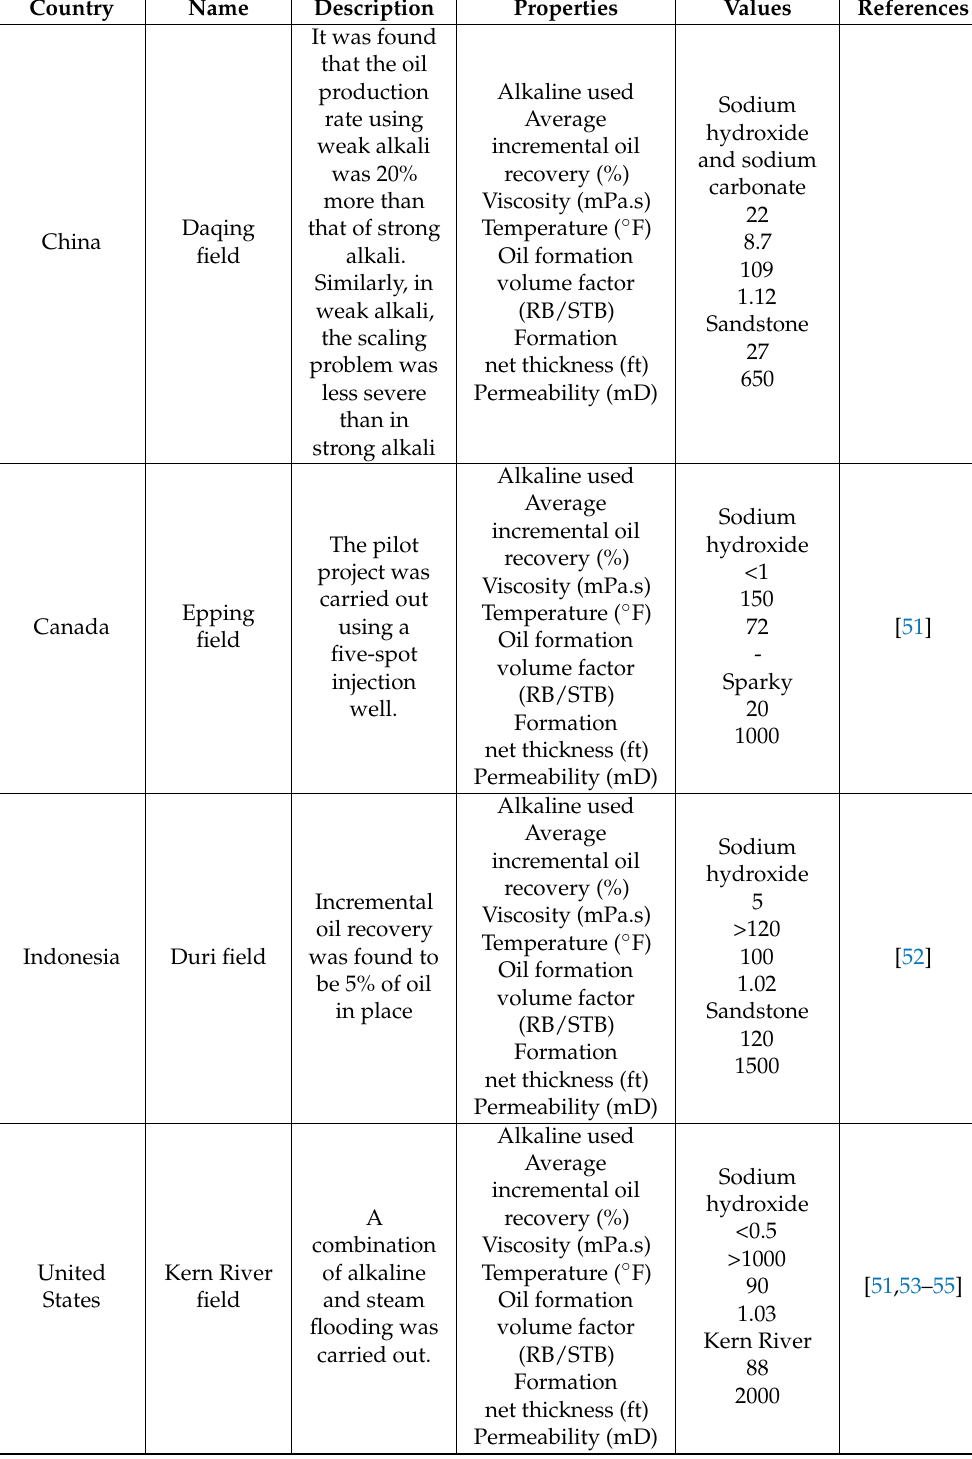
Table 1. Alkaline flooding—pilot